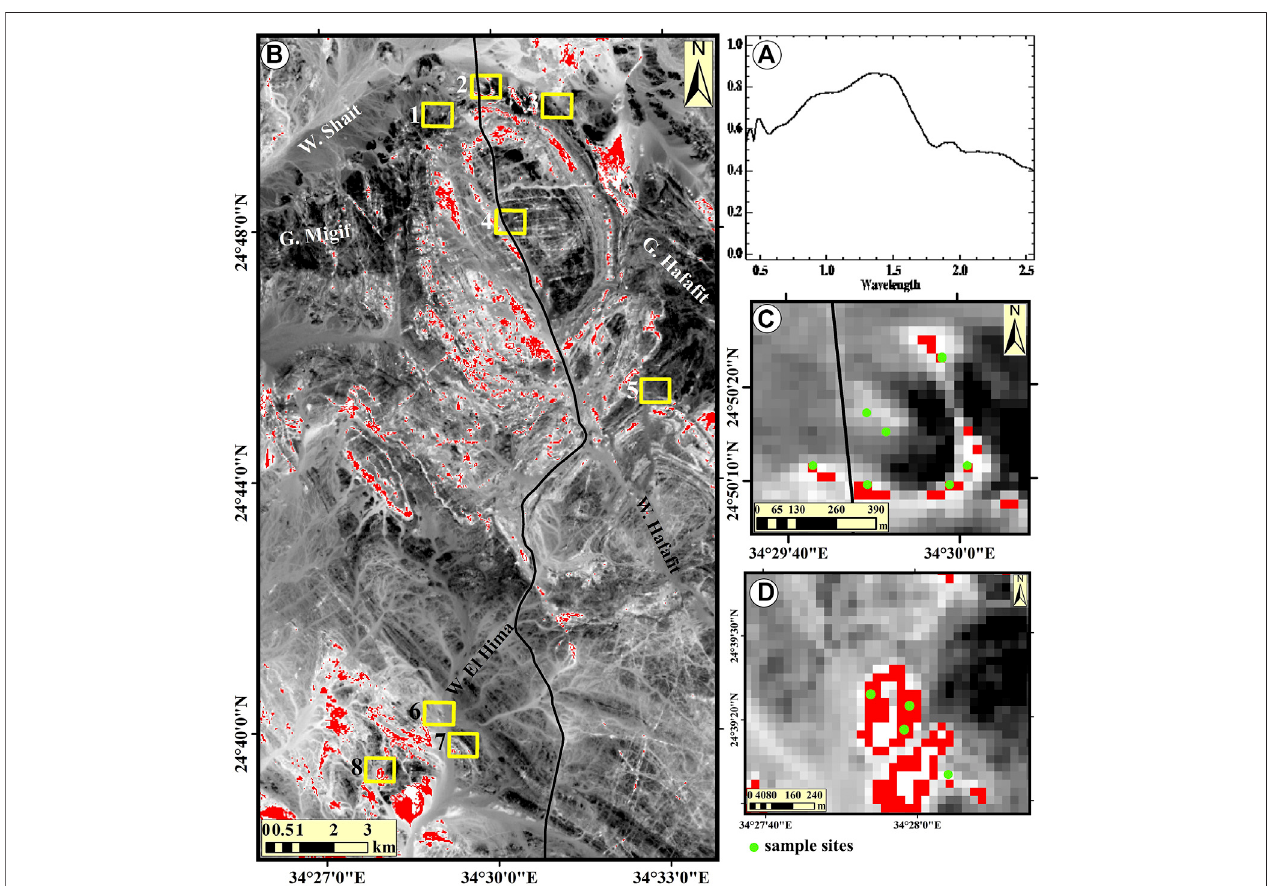
FIGURE6|(A) DiagramshowingtheUSGSspectraofcorundum, (B) CEMresults(redpixels)showingthepegmatitesandassociatedcorundumabundanceinthe study area drapped over Landsat-8 (6/7) band ratio, (C,D) showing the validation of the distribution of pegmatites using the matching of the sample locations in two areas; El Qarn area and South El Hima area,